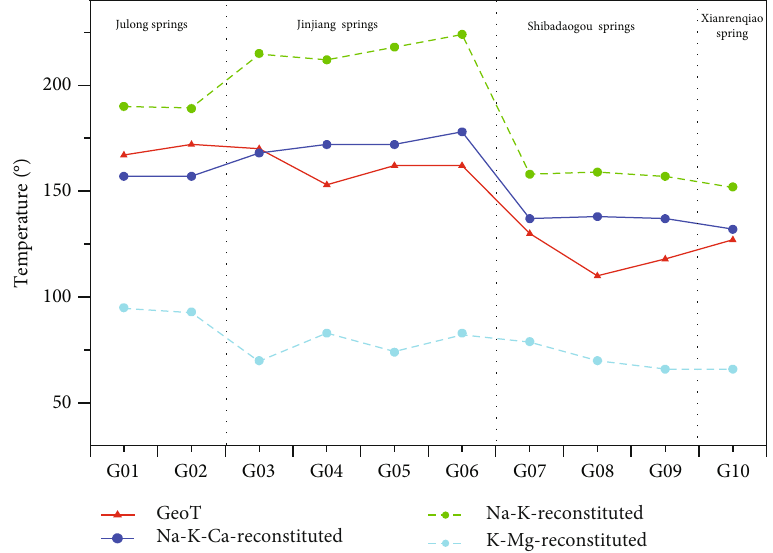
Figure 7: Di ff erence in temperature estimates for the reconstituted deep fl uid using classic